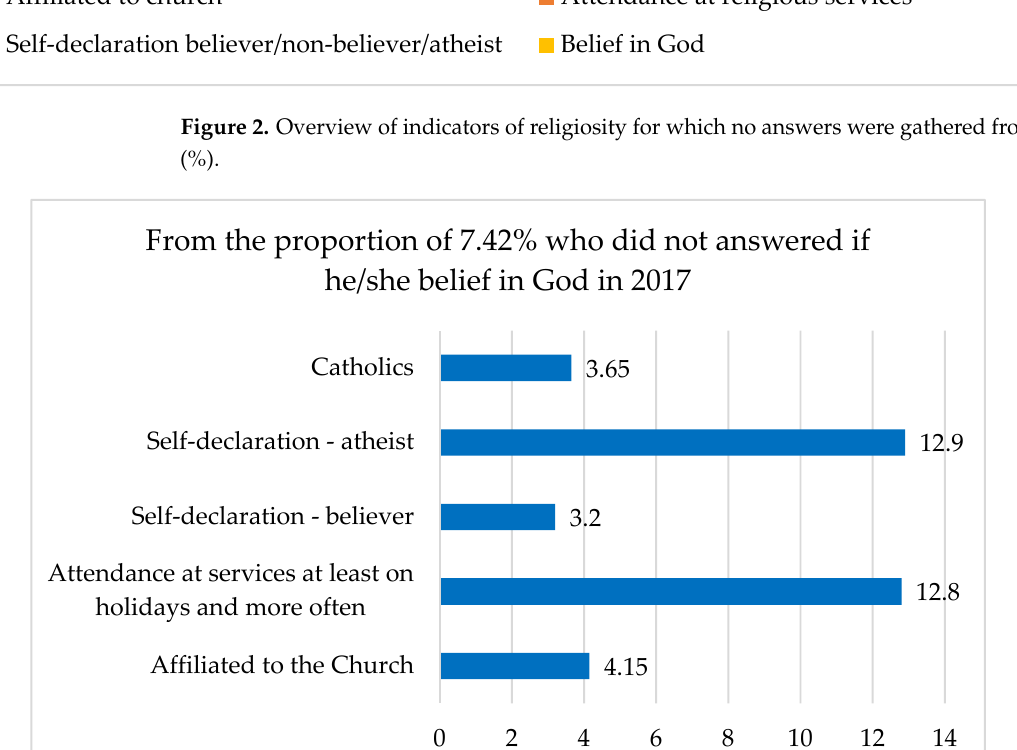
Figure 2. Overview of indicators of religiosity for which no answers were gathered from respond- ents (%).